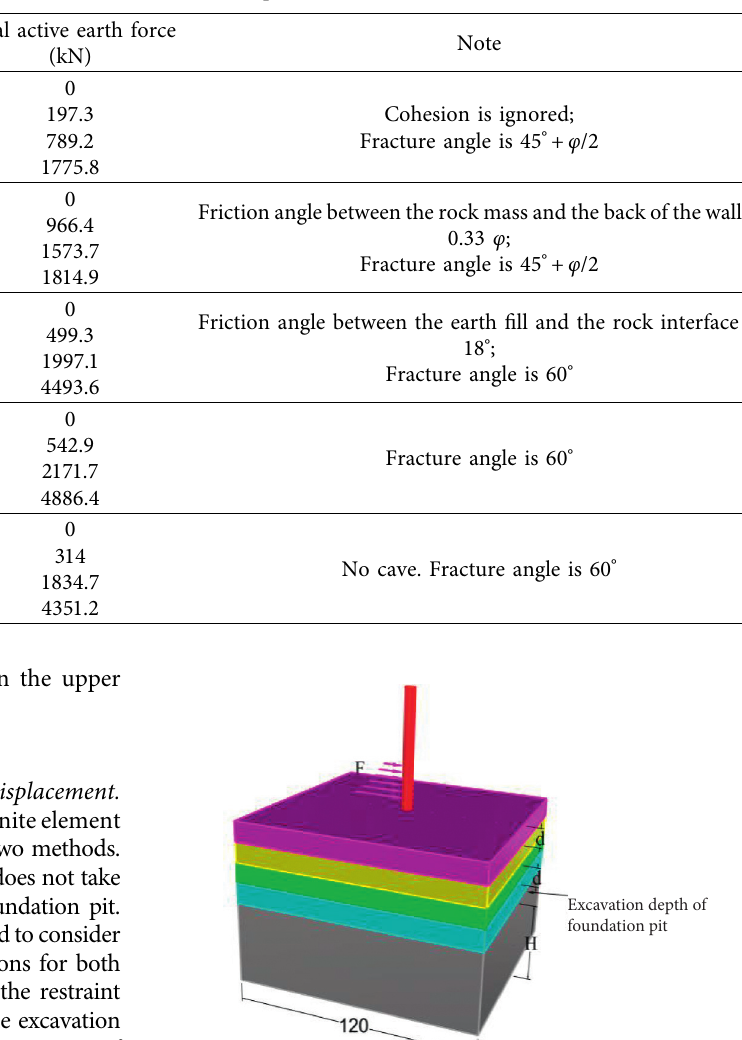
Table 1: Calculations of the earth pressure.